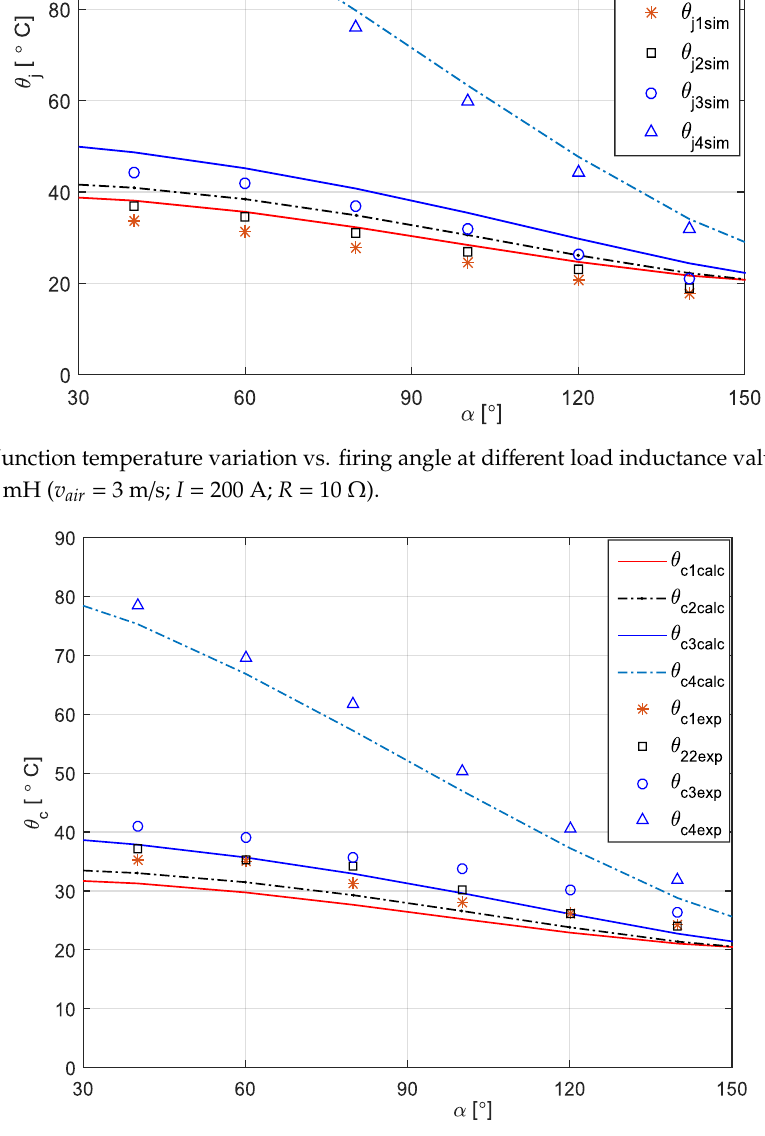
Figure 17. The Device Under Test experimental setup. The thermocouple provides a low magnitude voltage signal that needs to be amplified by a signal conditioning board SC, type AT2F-16 with the error of ±0.5%. The amplified voltage signal is used as input data for a data acquisition board type PC-LPM-16. This can be programmed using the LabVIEW software package. The sampling rate was 50 kS/s and the analogue inputs have a resolution on 12 bits. The three-phase power rectifier supplies the resistive-inductive load RL. In the case of temperature variation against firing angle for different air speed values, shown in Figure 10, the maximum case temperature is about 83.1 °C when the air speed is 1 m/s and the firing angle is 30 °el, and the minimum case temperature is 24.8 °C for a firing angle of 150 °el and the air speed of 6 m/s. It can to observed that the experimental values are higher than the calculated ones because, in fact, the semiconductor case does not cool evenly. Actually, due to the mounting technology of the power assembly (thyristor case between heatsinks of rather large sizes), the airflow does not cool the surface of the semiconductor case quite well. So, for instance at the firing angle of 90 °el, the experimental case temperature is 56.8 °C higher than the computed temperature